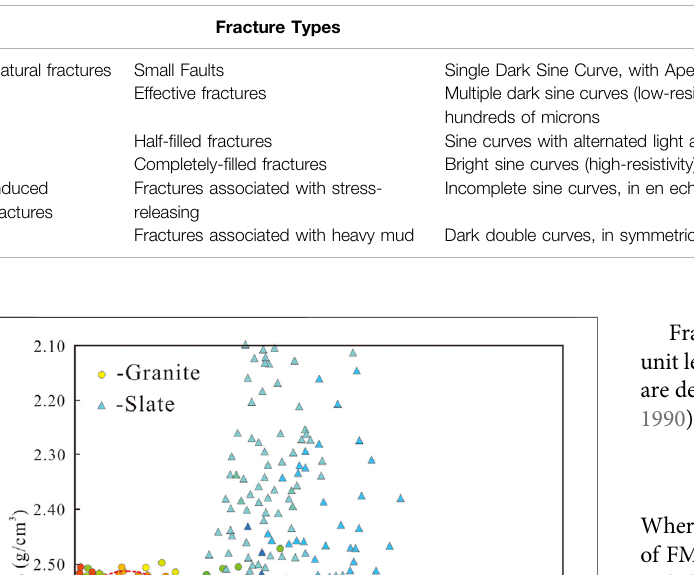
TABLE 1 | Fracture patterns on FMI